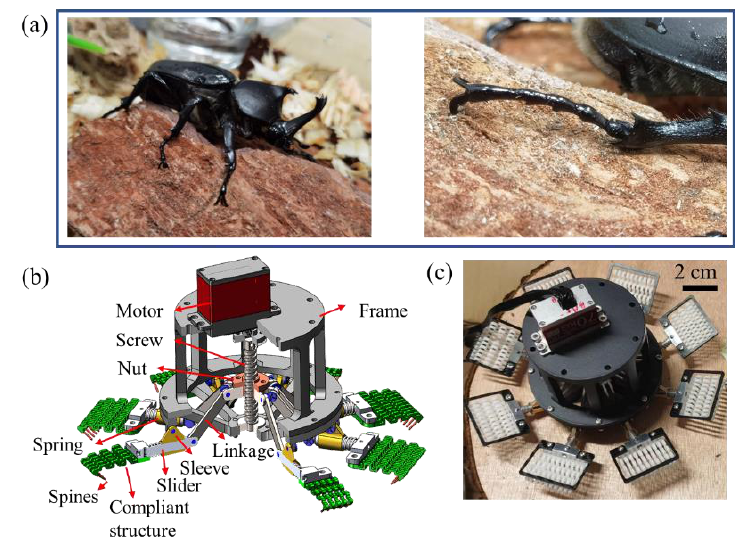
Figure 1. Design and fabrication of microspines gripper. ( a ) Bionic design motivation from Rhinoceros beetle (Coleoptera: Phileurus didymus ) attachment. ( b ) CAD (Computer-aided design) model of the microspines gripper. ( c ) The microspines gripper prototype.